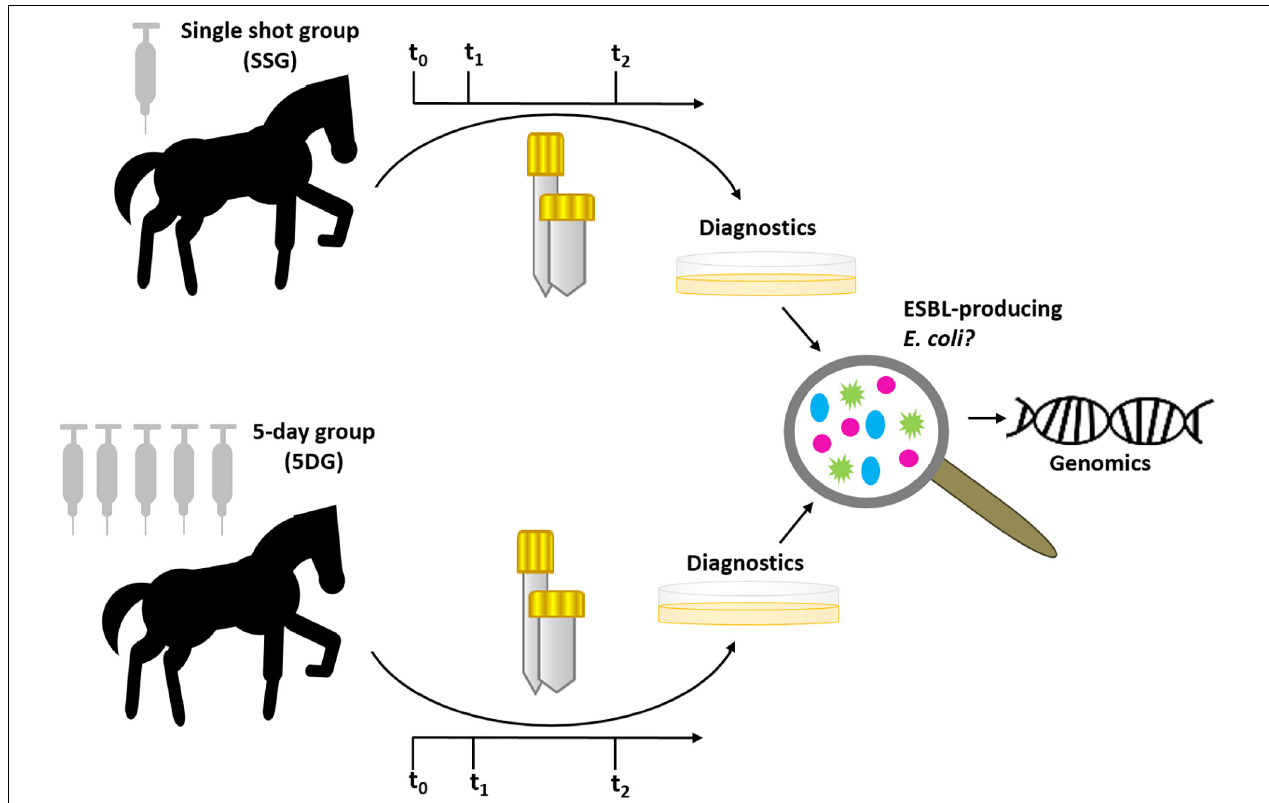
FIGURE 1 | Graphical abstract of the prospective study. Horses were assigned to either the “single-shot group” (SSG) or the “5-day group” (5DG) per lot (sealed envelope drawn directly at hospital admission). Fecal samples and nostril swabs were collected at t 0 (hospital admission), t 1 (3 days after surgery) and t 2 (10 days after surgery). All samples were screened for putative ESBL-EC, subjected to the confirmatory testing followed by AST and whole genome